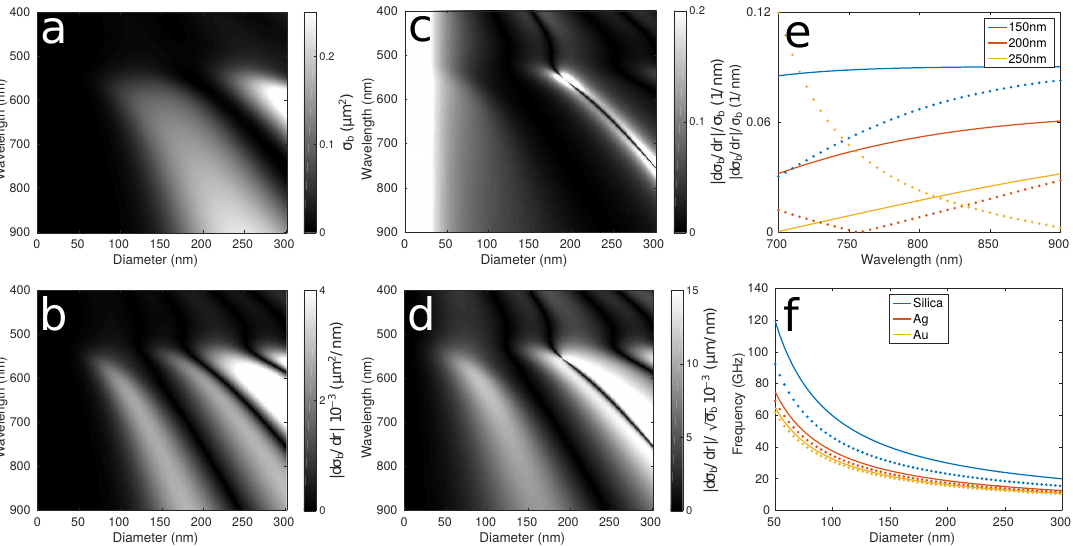
Figure 2. ( a ) theoretical backscattering cross-section [24] as a function of particle diameter and probe laser wavelength using Equation (2) for a gold nanoparticle in water; ( b ) optical sensitivity defined as the change in scattered light over 1 nm change in the radius of the particle; ( c ) modulation depth (optical sensitivity divided by the backscattering cross-section); ( d ) the optical sensitivity with respect to the signal-to-noise ratio (SNR) assuming optical shot noise; ( e ) theoretical change in modulation depth per nm for a 150, 200 and 250 nm gold nanoparticles in air (lines) and water (dots), calculated by the Mie model; ( f ) theoretical breathing mode frequency for a nanoparticle of silica, silver (Ag) and gold (Au) in air (lines) and water (dots), calculated by the mechanical